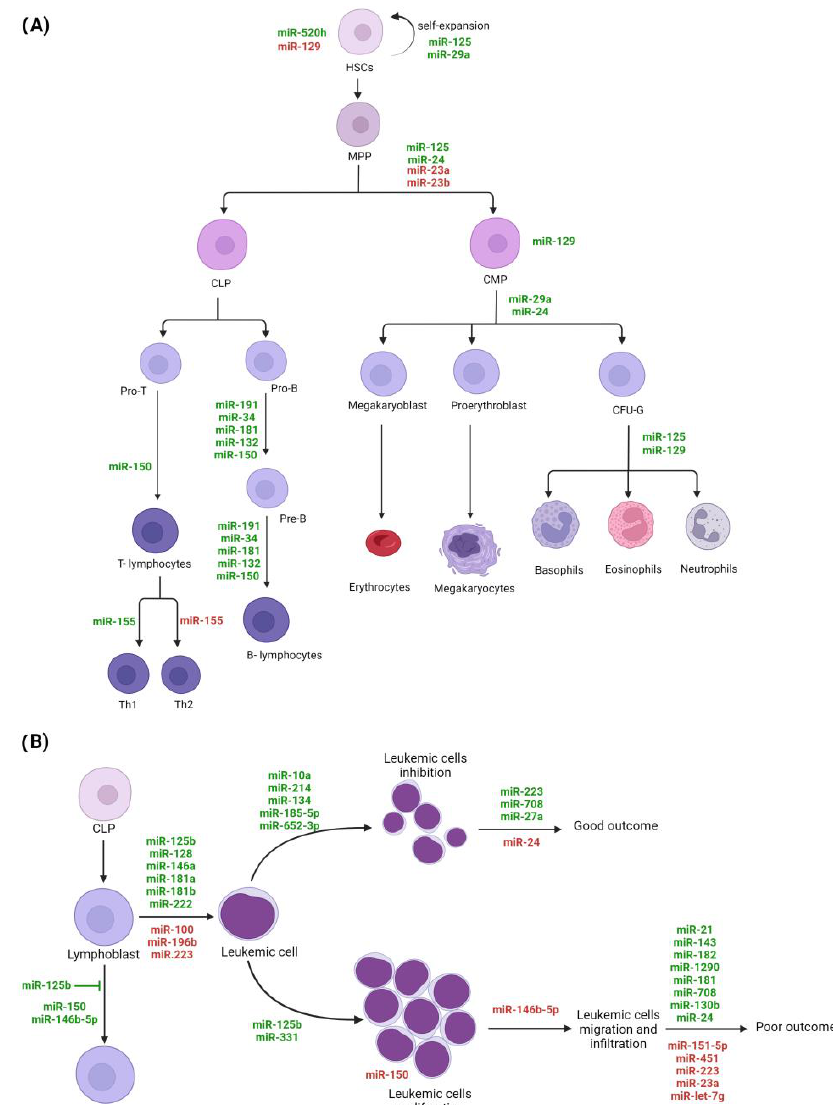
Figure 2. The miRNAs potentially implicated in hematopoiesis and leukemogenesis. ( A ) Hematopoiesis process is schematized, and examples of miRNAs expressed involved in the cell differentiation and maturation are indicated. ( B ) The miRNAs with dysregulated expression that are potentially involved in oncogenic lymphoblast transformation and progression are shown. MiRNAs in red means downregulation, and miRNAs in green means upregulation; HSCs, hematopoietic stem cells; MPP, multipotent progenitors; CLP, common lymphoid progenitors; CMP, common myeloid progenitors; CFU-G, granulocytic colony-forming unit.